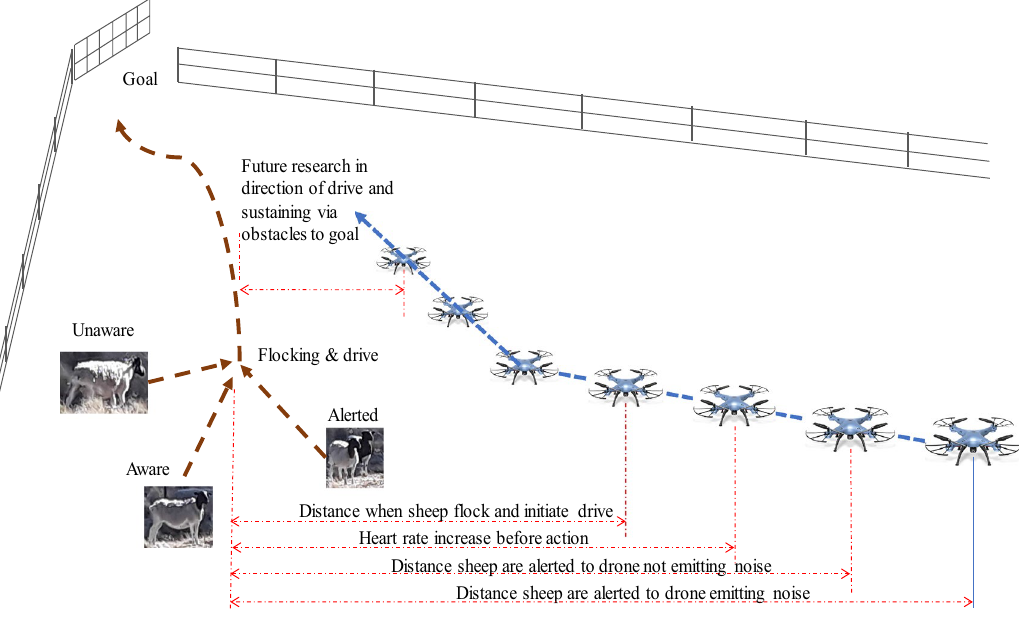
Figure 1. Expected proximal response of sheep to the presence of a Sky Shepherd.